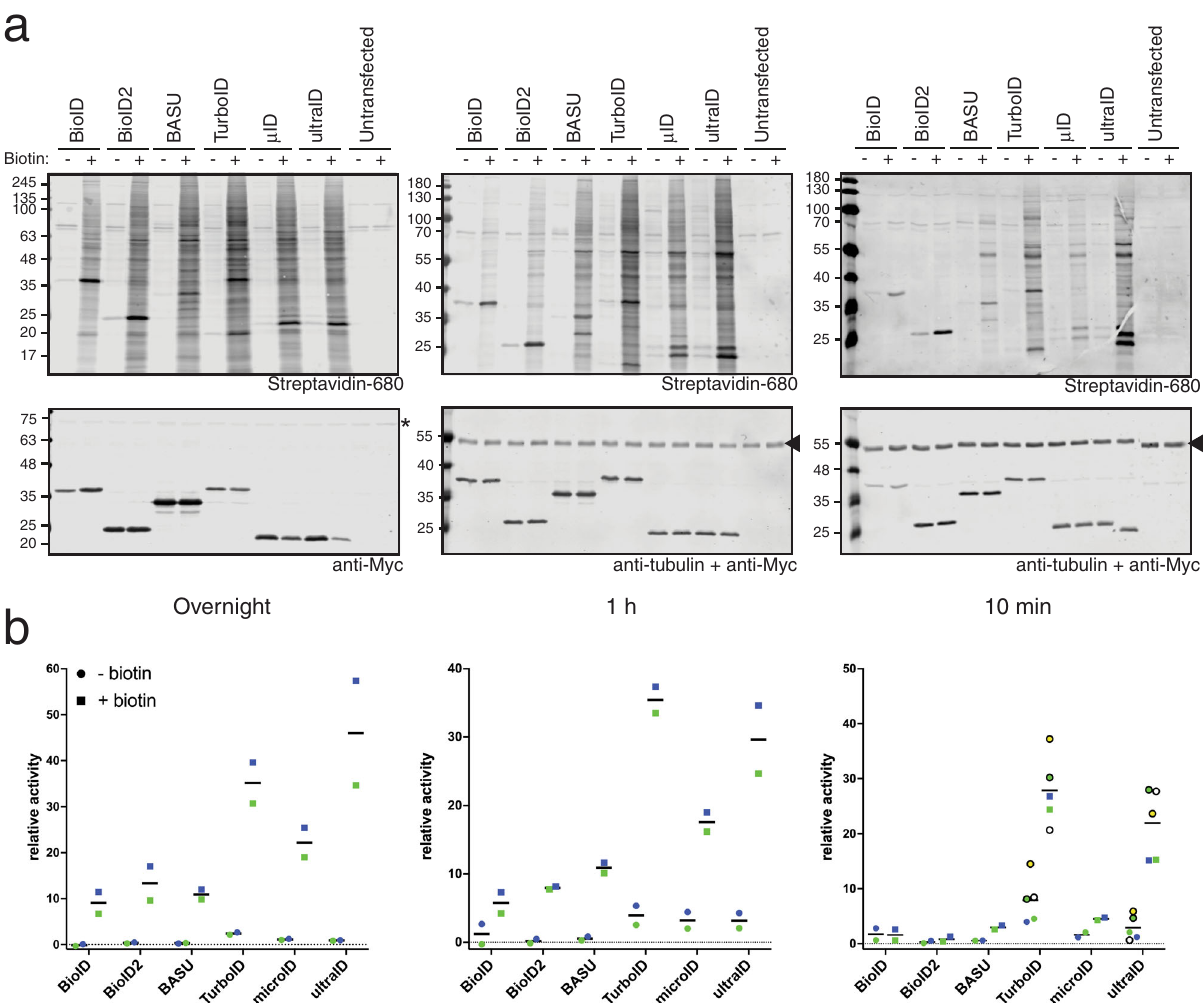
Fig. 5 ultraID outperforms current PDB enzymes. a Blots of lysates of HeLa cells transiently transfected with the indicated constructs and incubated ( + ) or not ( − ) with 50 μ M biotin overnight (left), for 1 h (middle), or for 10 min (right). Biotinylation was analyzed using IRDye680-labeled streptavidin and expression levels of the fusion proteins with antibodies against the Myc tag as indicated. The asterisk (*, overnight condition) indicates a non-speci fi c cross-reactivity that was used as a loading control. The arrowhead (1 h and 10 min conditions) indicates the tubulin signal that was used as a loading control. b Quanti fi cation of a . Circles and squares of the same color belong to the same replicate